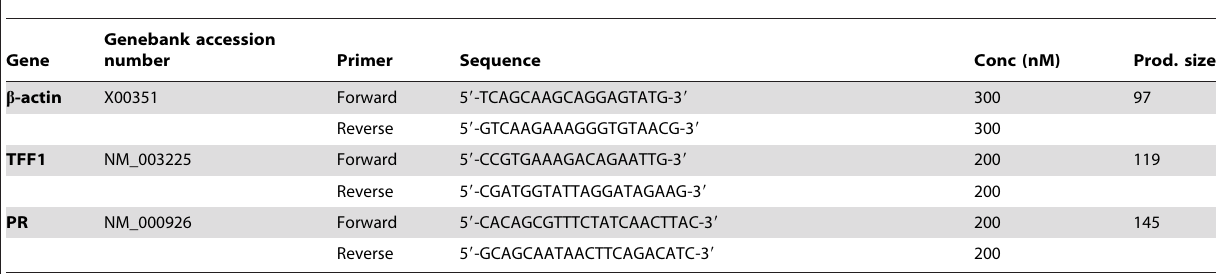
Table 1. Sequence of primers for real-time